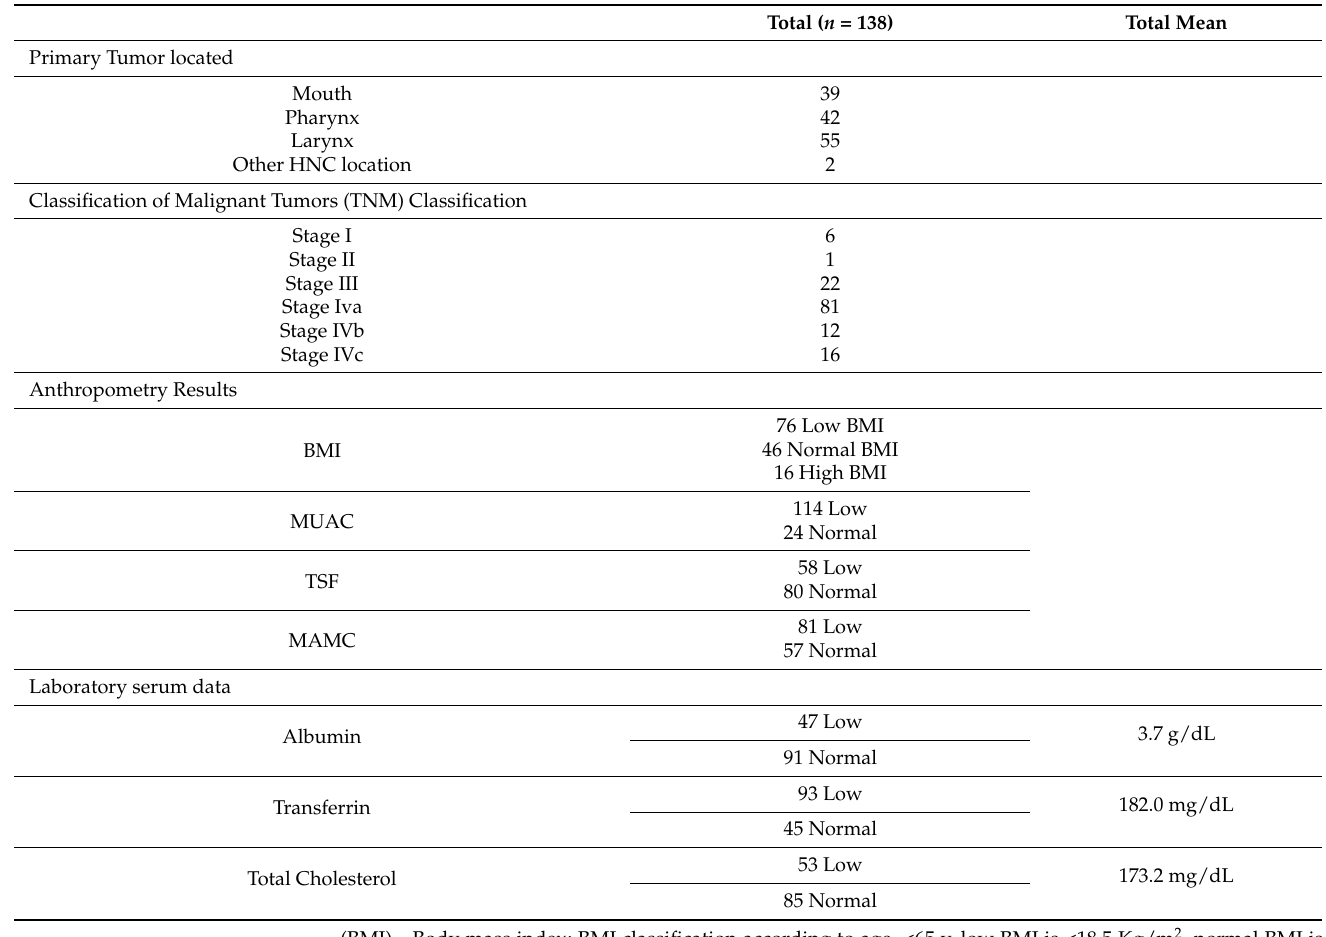
Table 3. Characterization of subjects by primary tumor location, TNM classification, anthropometry and laboratory serum